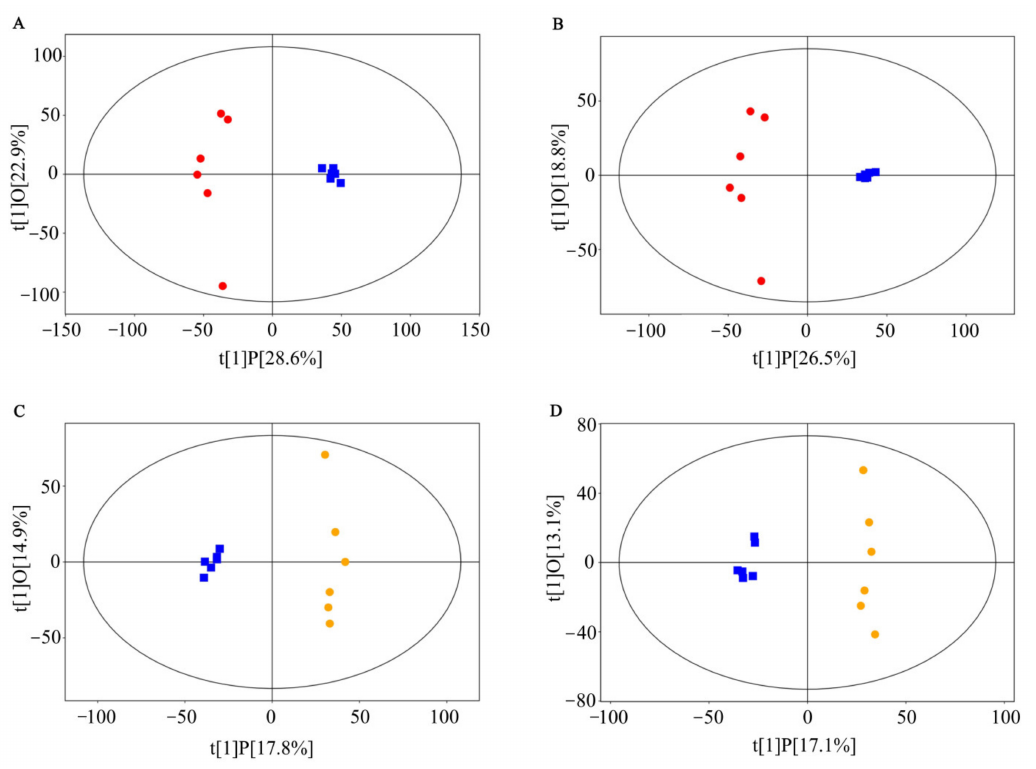
Figure 1. OPLS-DA score scatter plots of serum metabolites after L. plantarum FRT4 intervention. ( A ) HF versus CT group in ESI+ mode. ( B ) HF versus CT group in ESI- mode. ( C ) HF4H versus HF group in ESI+ mode. ( D ) HF4H versus HF group in ESI-